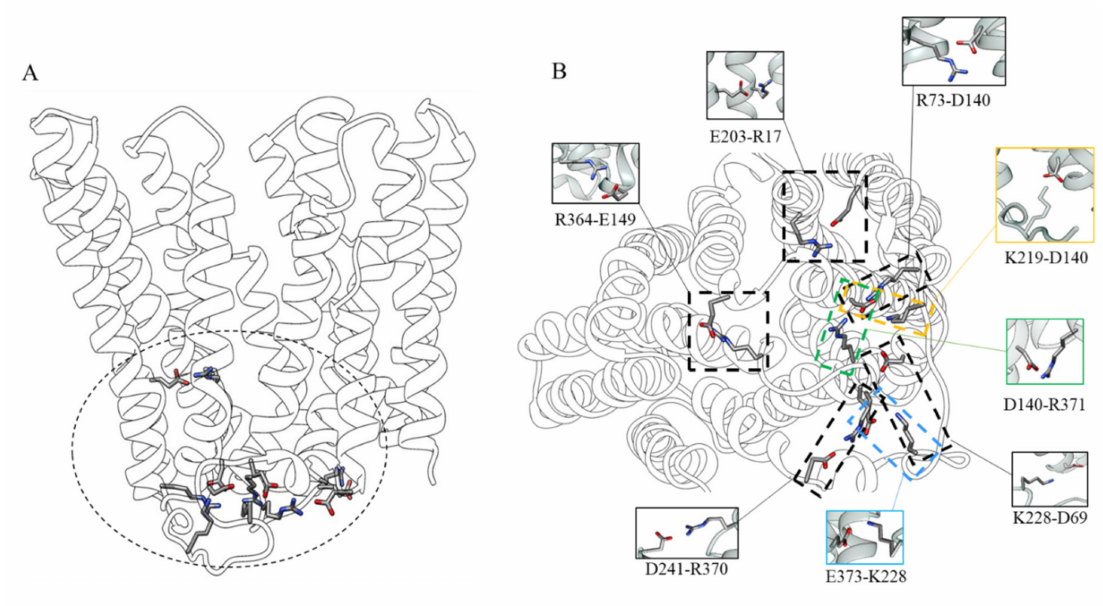
Figure 5. ( A ) Residues interaction network involved in the stability of the outward-facing state viewed along the membrane plane; ( B ) View of the intracellular-side with focus on the residue